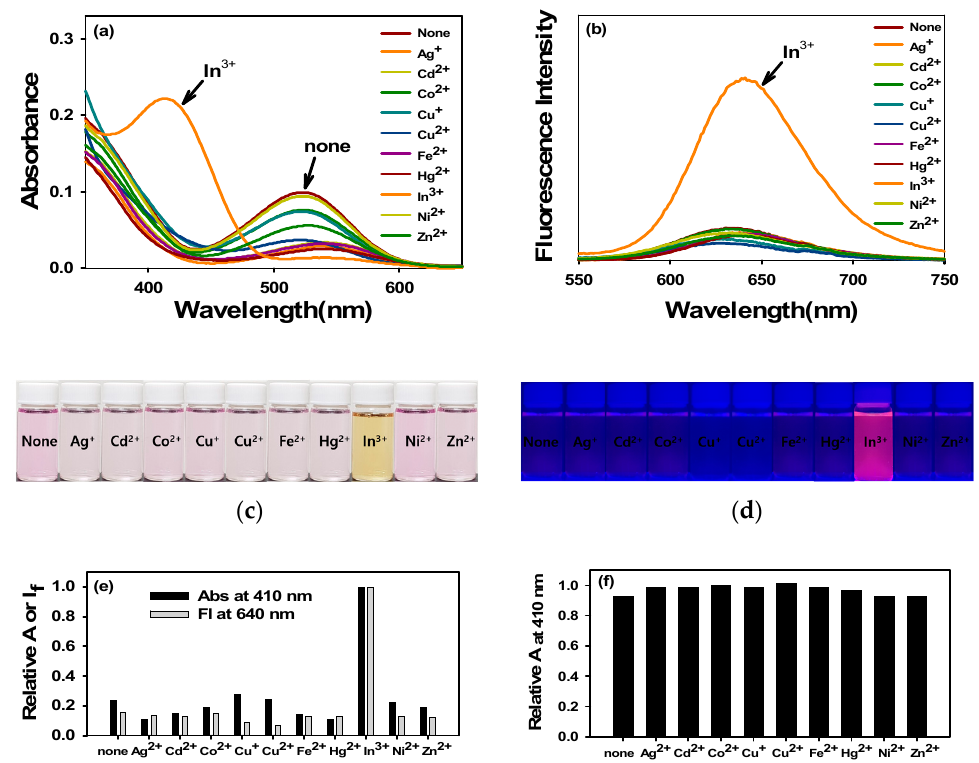
Figure 9. ( a ) Absorption spectra, ( b ) fluorescence spectra, ( c ) photograph of visual color change, ( d ) photograph of fluorescence change, and ( e ) relative absorbance and fluorescence intensity of SP-IQ after placed in the dark for 7 h with the absence and the presence of various metal cations; and ( f ) relative absorbance of SP-IQ after being placed in the dark for 7 h with the absence and the presence of various metal cations (1 × 10 − 4 M; Ag 2+ , Cd 2+ , Co 2+ , Cu + , Cu 2+ , Fe 2+ , Hg 2+ , In 3+ , Ni 2+ , Zn 2+ ) in the presence of In 3+ (1 × 10 − 4 M).